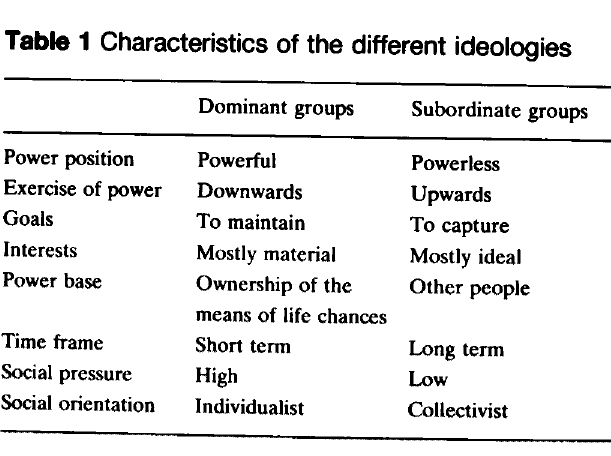
Table 1 Characteristics of the different ideologies Dominant